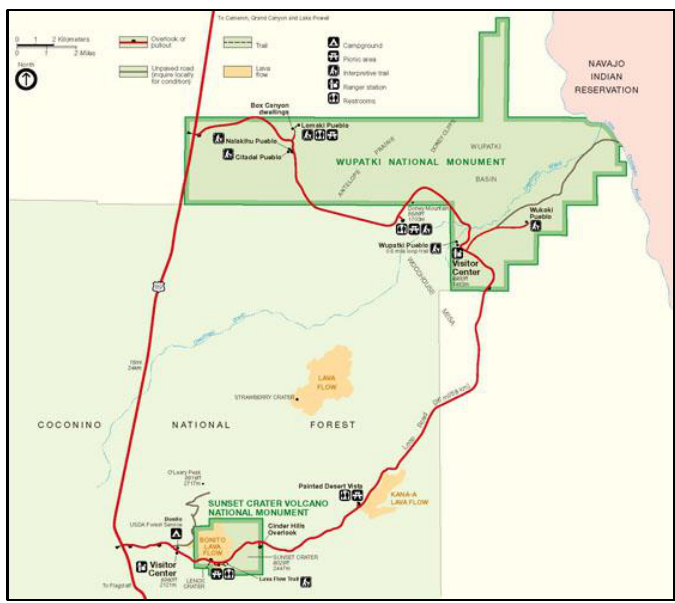
Figure 4. Official NPS Map of Wupatki and Sunset Crater Volcano National